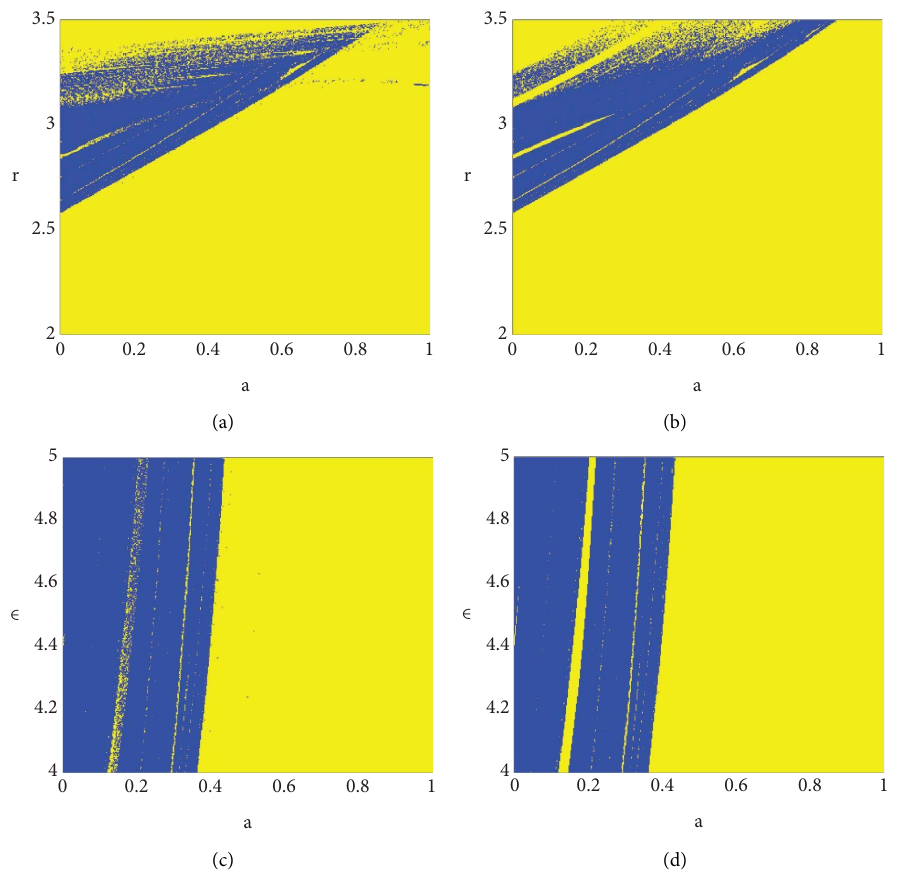
Figure 11: (a, b) Dynamical map with respect to the parameters a and r with ε � 4 . 8 and initial conditions (0.08, 0.08) and initial conditions (0.7, 0.7), respectively. (c, d) Dynamical map with respect to the parameters a and ε with r � 3 and initial conditions (0.08, 0.08) and initial conditions (0.7, 0.7), respectively.